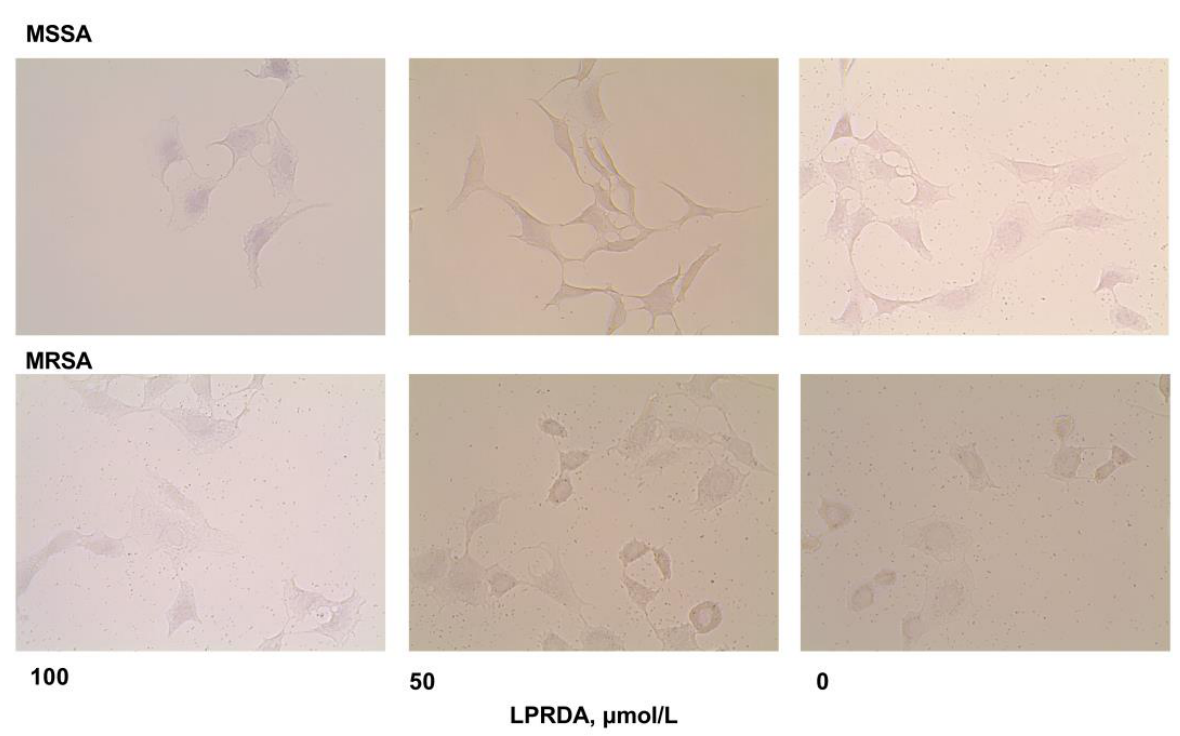
Figure 2. Microphotographs of S. aureus ATCC 29213 (MSSA) and S. aureus ATCC 43300 (MRSA) interactions with Vero cells (at 40-fold magnification) after preliminary incubation of staphylococci with LPRDA.